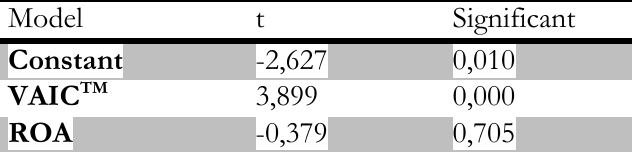
Table 4. Results (t test)